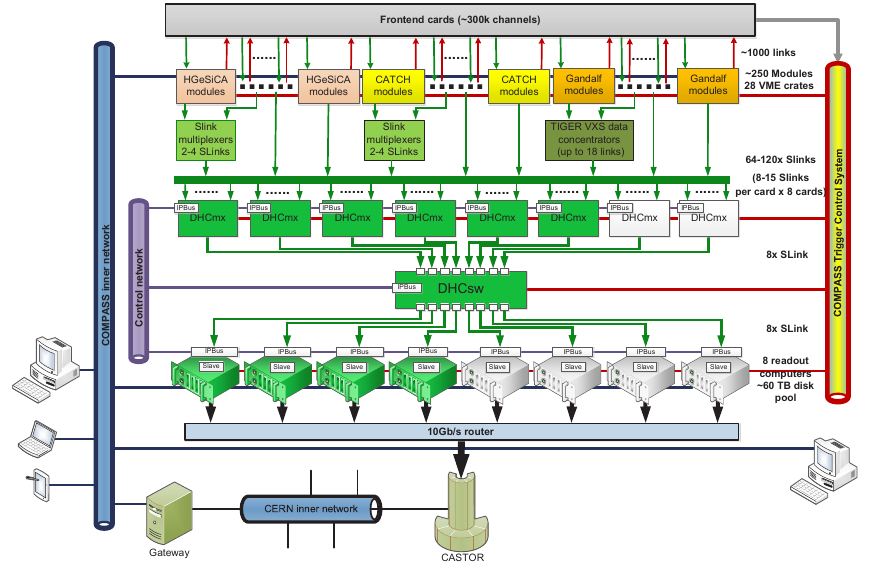
Figure 1. The COMPASS iFDAQ